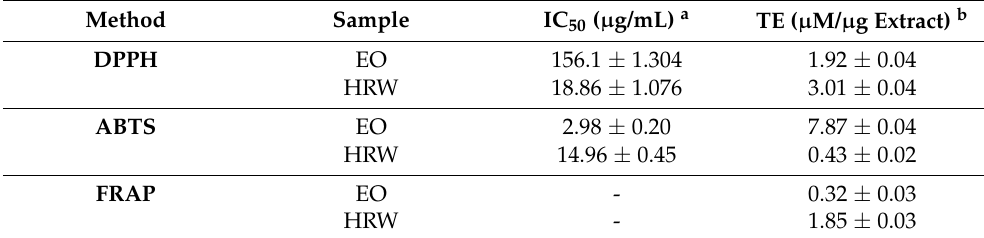
Table 3. Antioxidant activity of essential oil (EO) and hydrodistillation residual water (HRW) from T. capitata by DPPH, ABTS, and FRAP